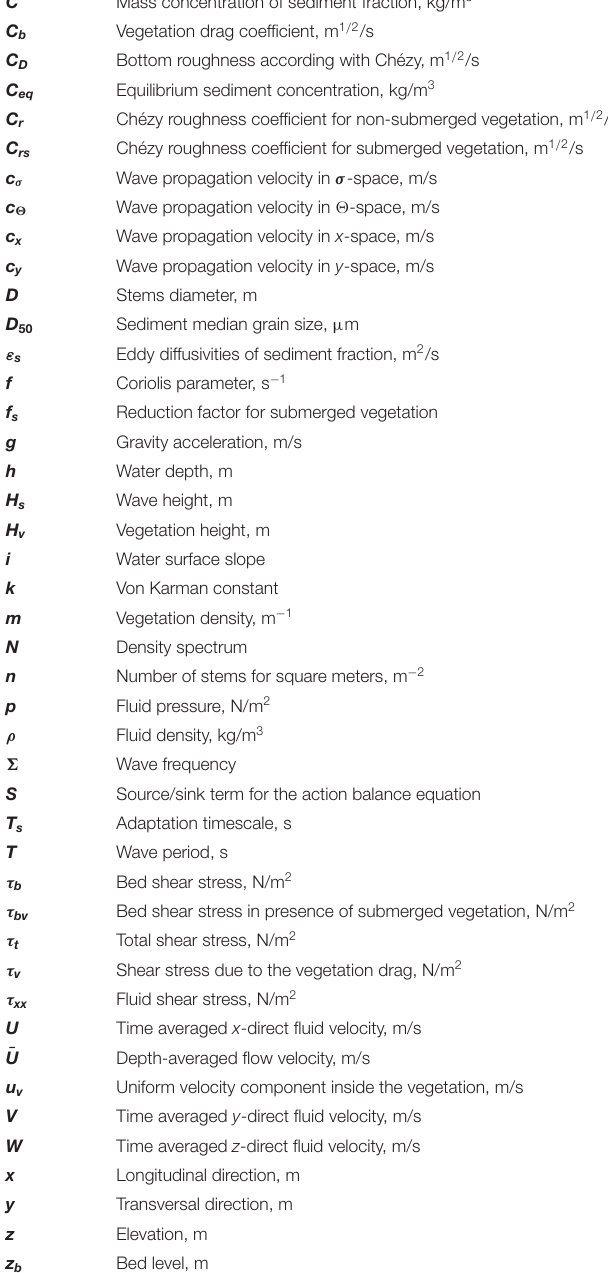
TABLE 1 | Notation of Delft3D governing